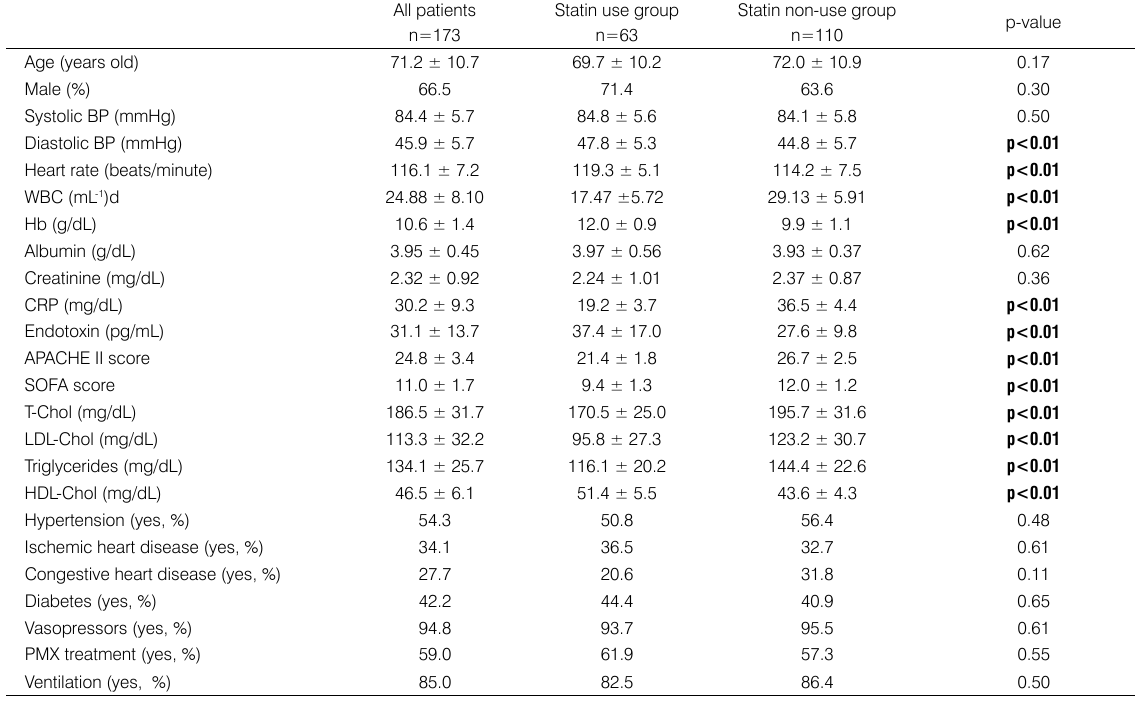
Table 1. Baseline characteristics of statin use or non-use